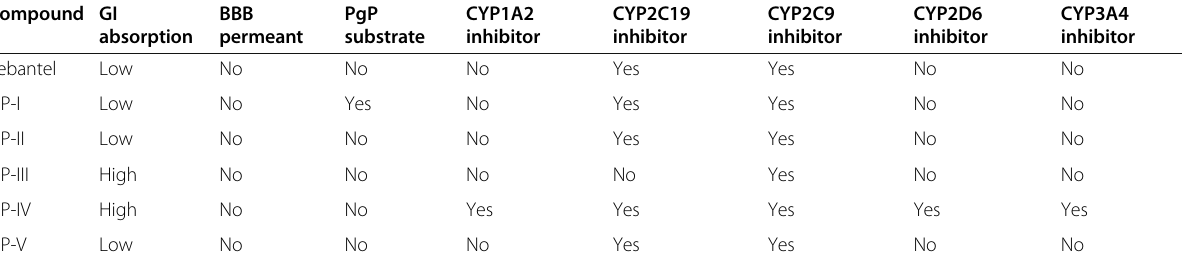
Table 5 Results of in-silico ADME properties and toxicity data recorded for drug and degradation products using Swiss ADME Compound GI absorption